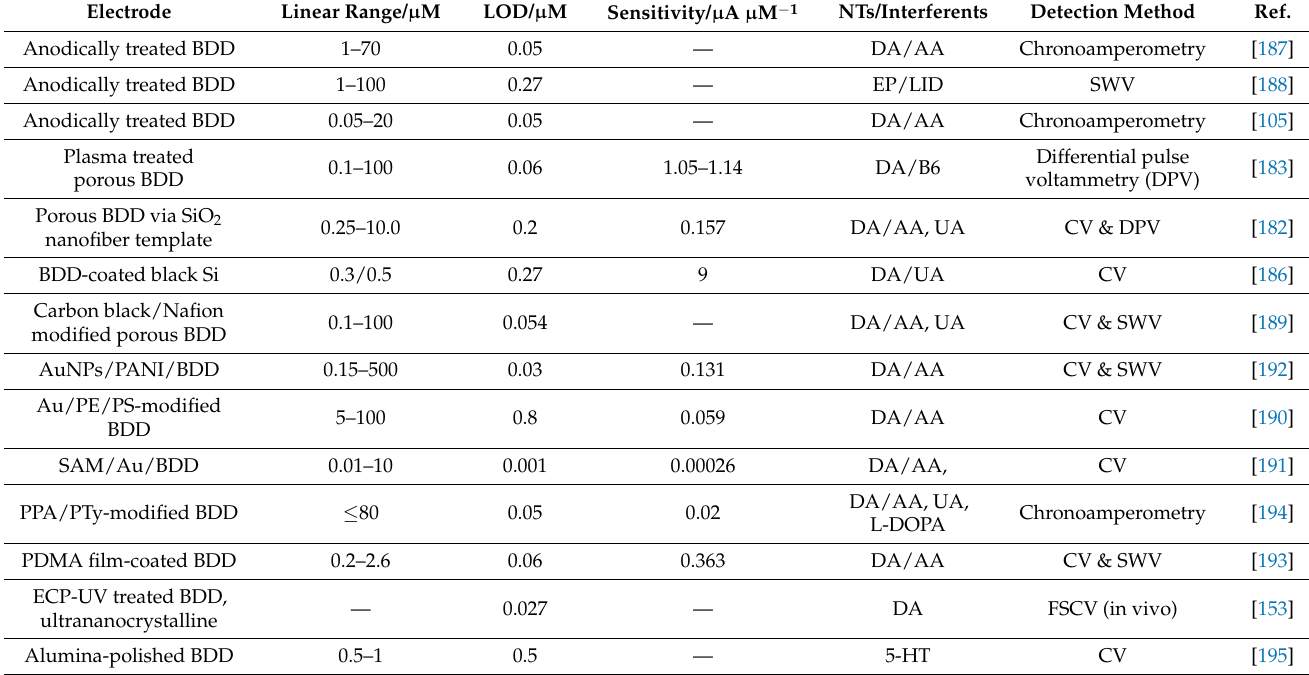
Table 3. Comparison of various modification strategies for BDD